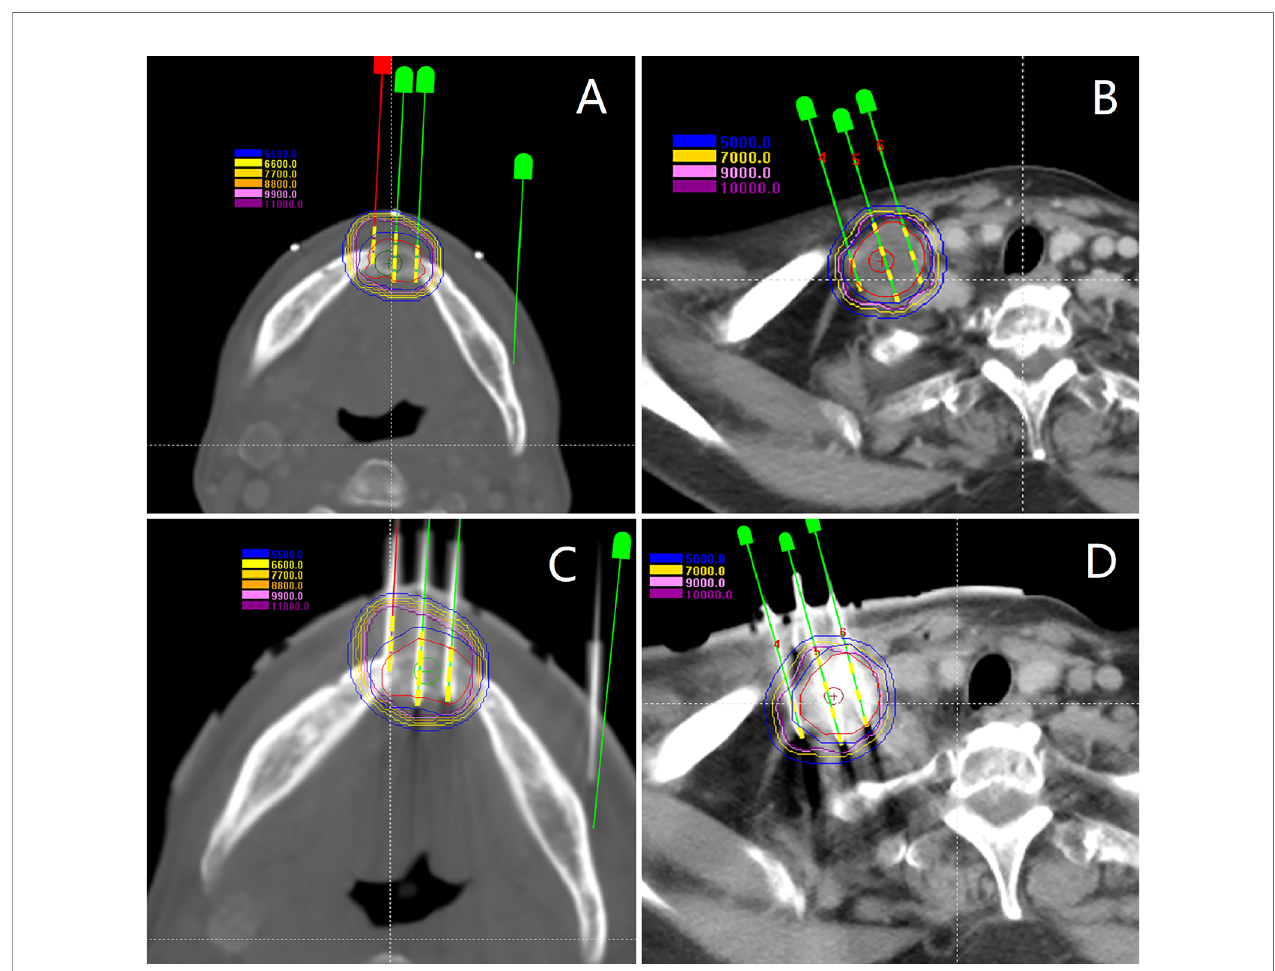
FIGURE 4 | (A, B) Intraoperative plan and the additional needle was added; (C, D) I 125 seeds were